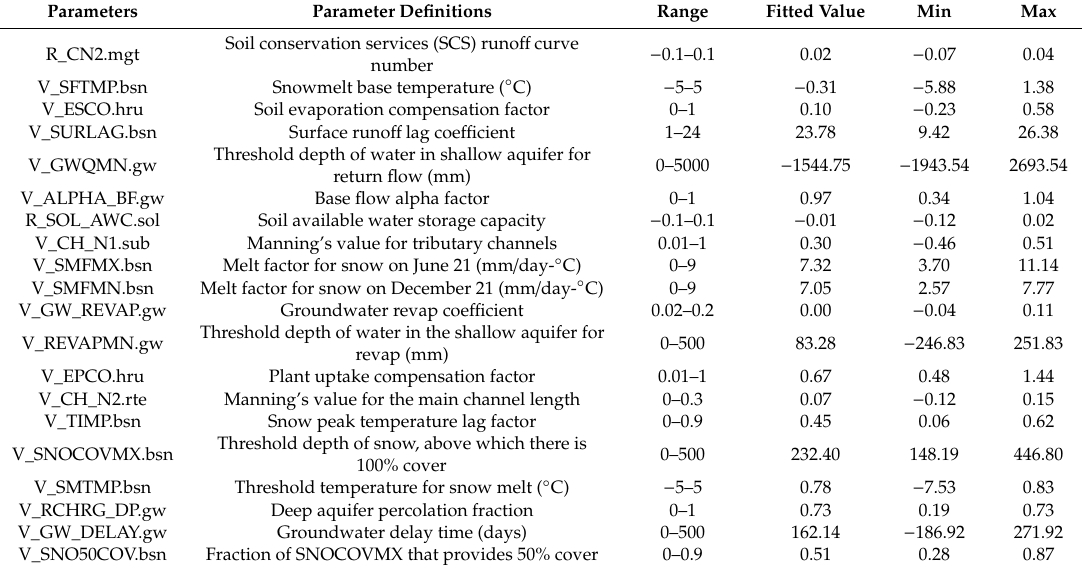
Table 6. The parameters and values used in the